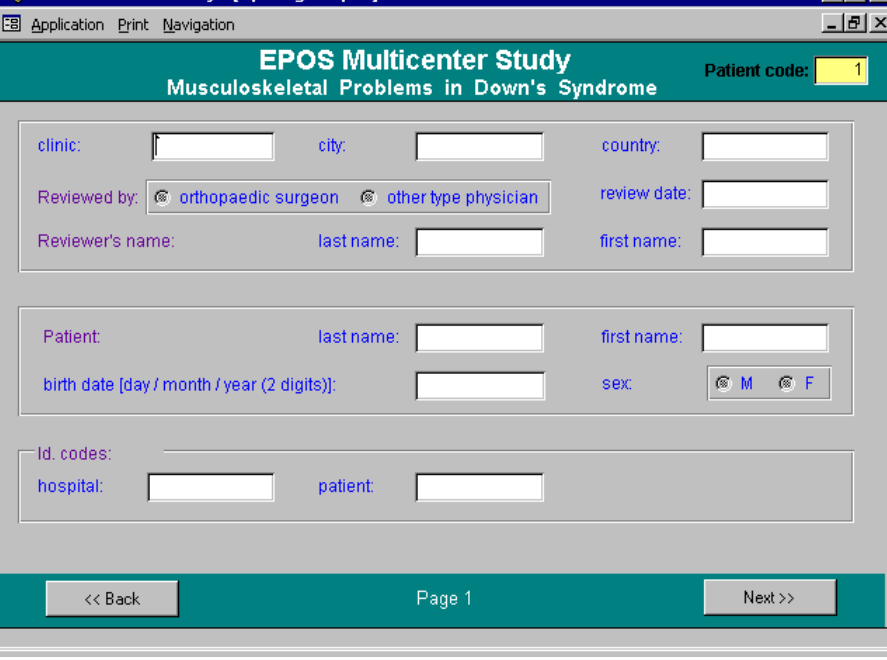
FIGURE 2 . The initial data entry screen in the electronic